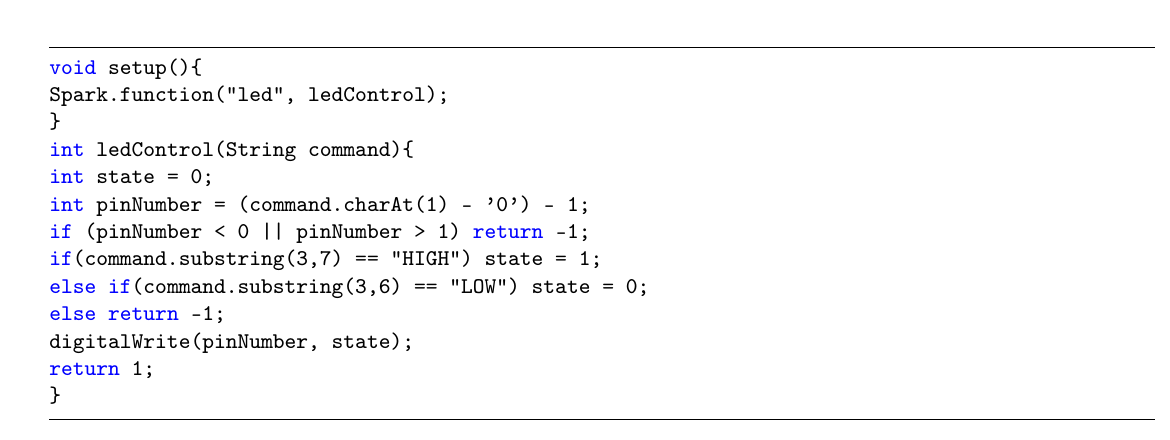
Figure 4. Particle.io code example for enabling/disabling an arbitrary digital pin.